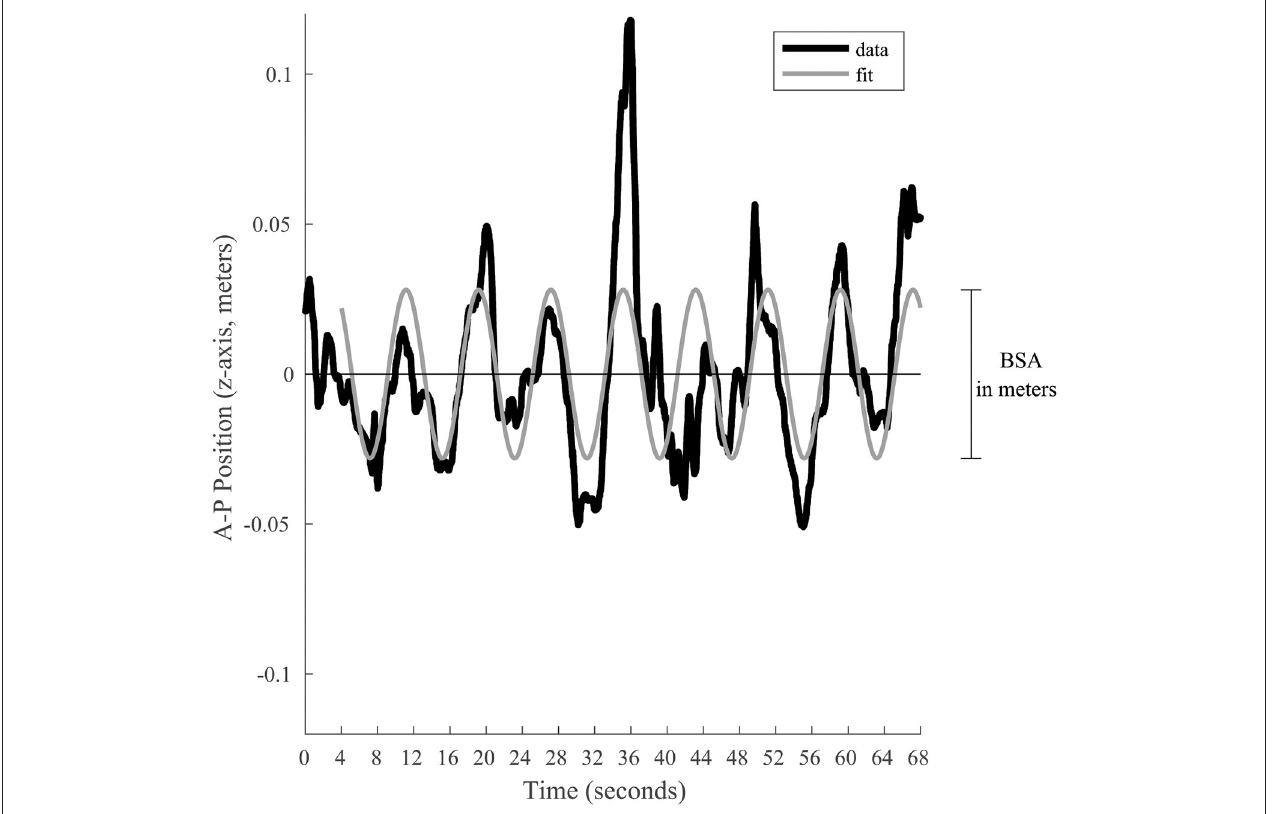
FIGURE 2 | Graphical representation of the BSA calculation for a given trial. The black line represents the position along the anterior-posterior axis. To estimate the postural response of the subject, a sine wave (gray line) is fitted to the last 64s. This sine wave is constrained to have a frequency equal to the visual stimulation. Its total amplitude represents the BSA in meters, which is afterwards converted in degrees of angular